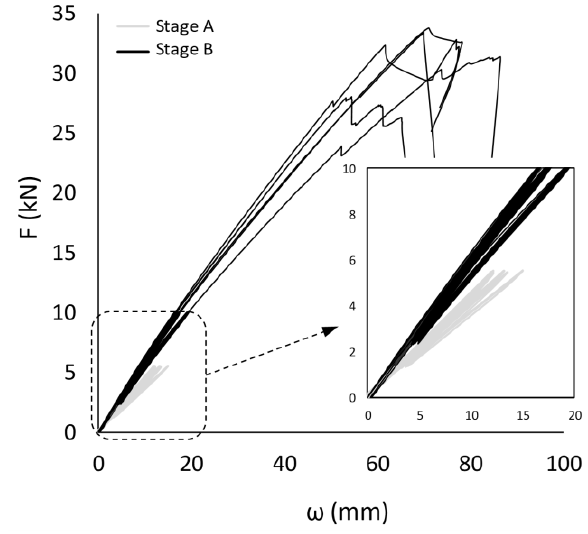
Figure 7. The load–deflection curves of the large-scale DLT panels. Figure 7. The load – deflection curves of the large-scale DLT panels. Table 3. The bending properties of the large-scale DLT panels. Table 3. The bending properties of the large-scale DLT panels.